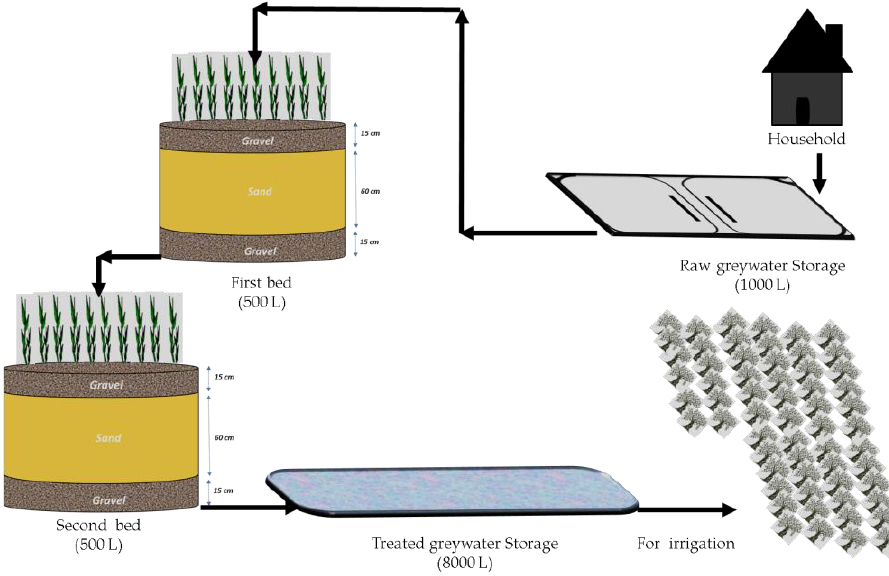
Figure 1. Scheme of greywater treatment unit.